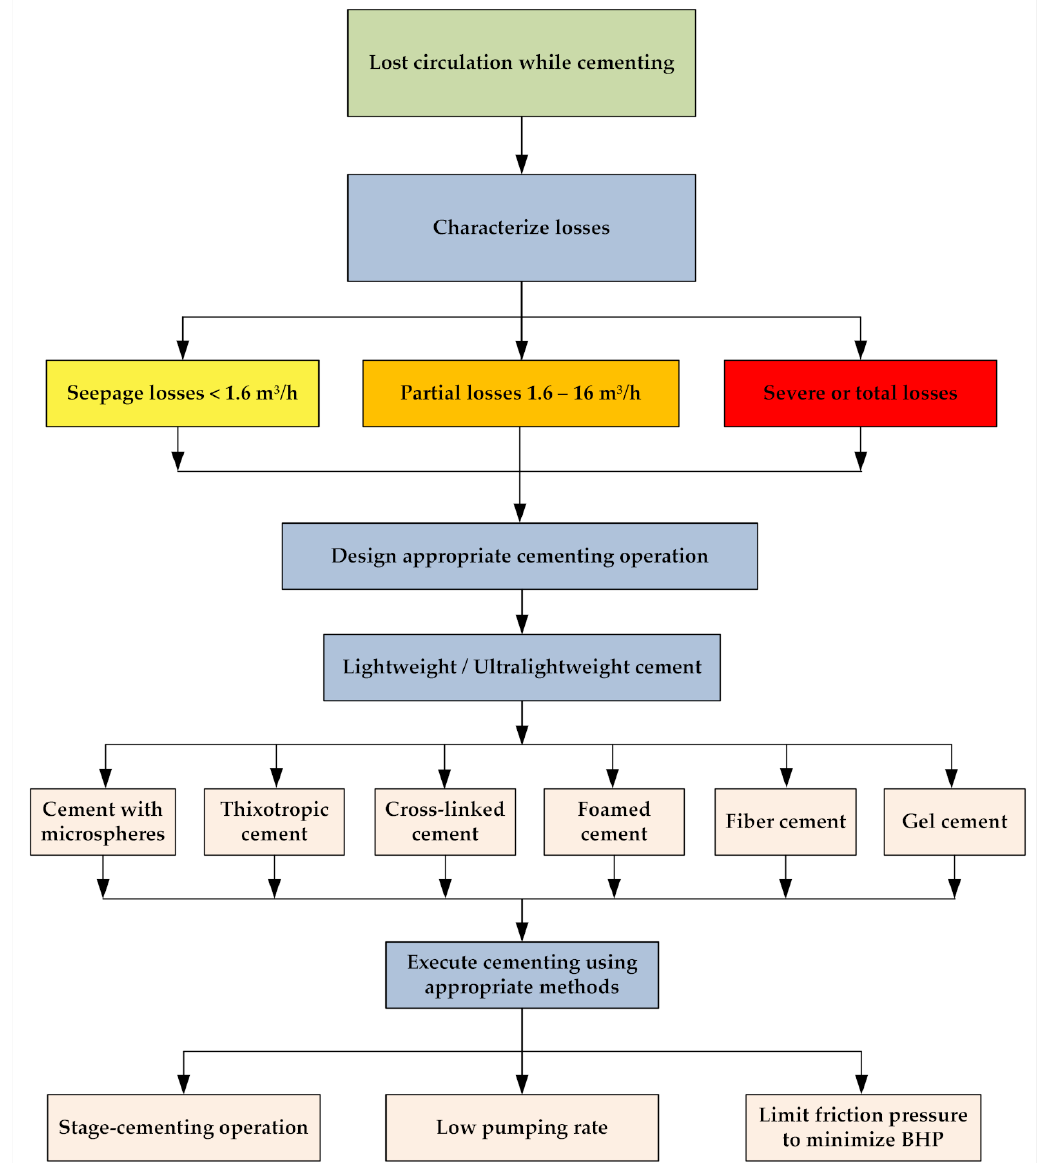
Figure 7. Sequence of procedures for solving the problem of loss of circulation during casing